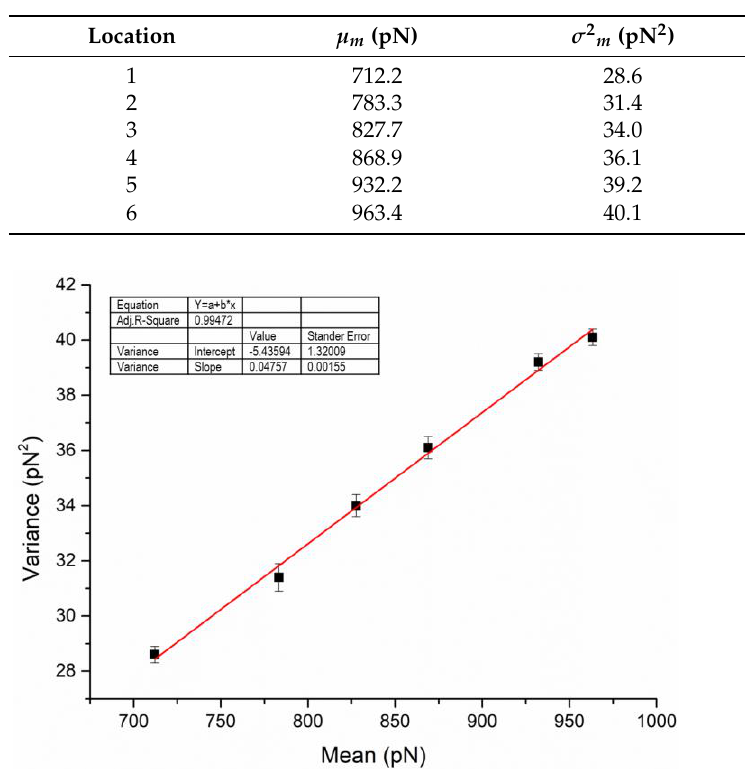
Table 1. Results of the adhesion forces between HSA pairs in the control (PBS).